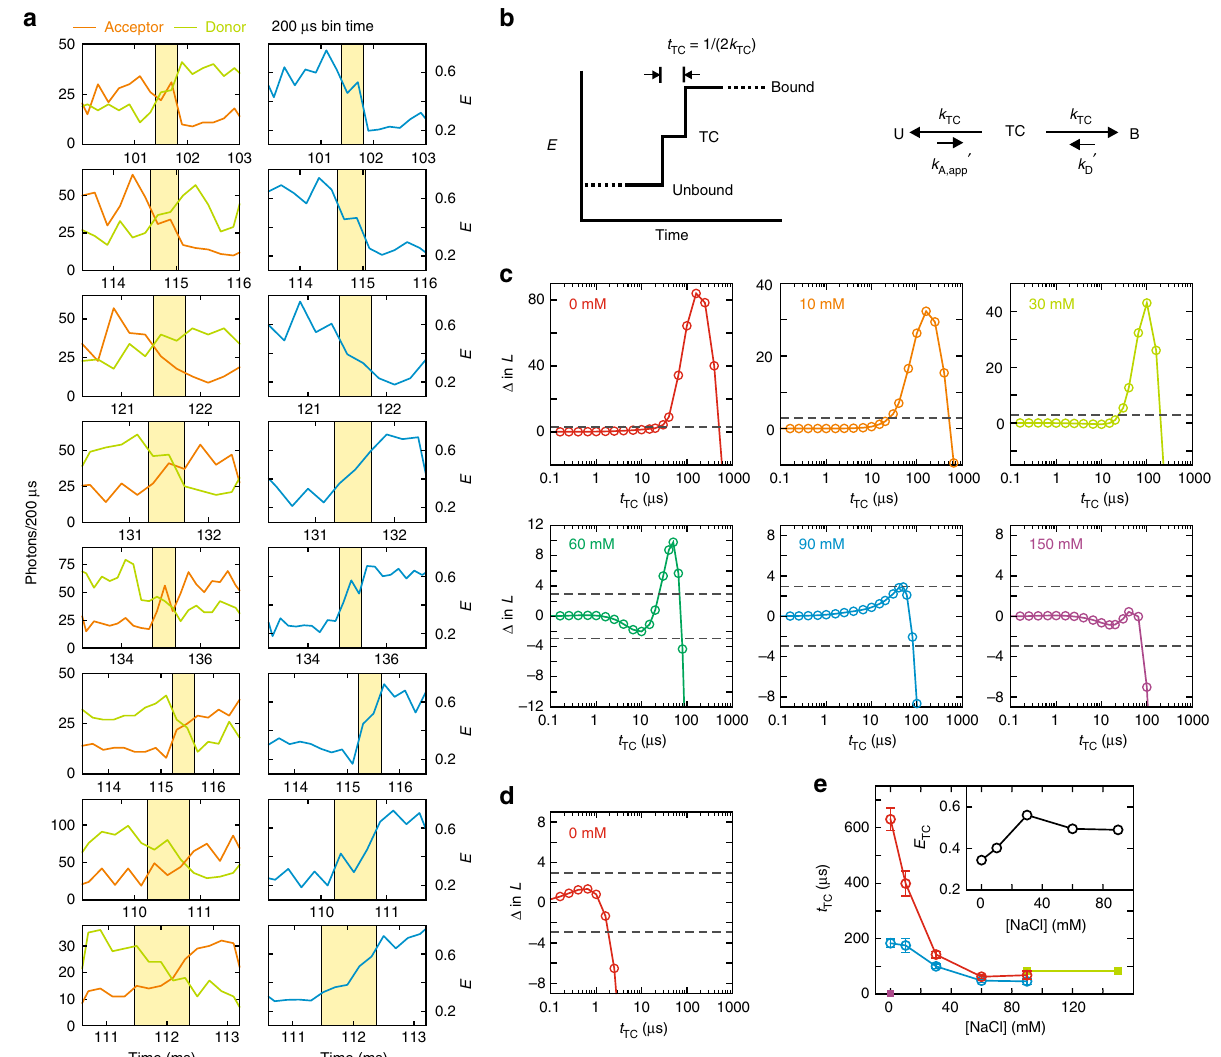
Fig. 3 Measurement of the lifetime of transient complex. a Selected donor and acceptor fl uorescence trajectories (left) and FRET ef fi ciency trajectories (right) collected at high illumination intensity (200 μ s bin time) that exhibit gradual changes in the fl uorescence intensities and FRET ef fi ciency (yellow shade) during association and dissociation. The accurate lifetime of TC was determined using the maximum likelihood analysis of photon trajectories without binning (see e ). b Three-state model to determine the lifetime of TC ( t TC ). The two rate coef fi cients of the transitions from TC to the bound and unbound states are set to be equal ( k TC ) for the convenience of the analysis, which does not re fl ect the actual relative heights of the two barriers in Fig. 4c. c The difference of log-likelihood ( Δ ln L ) plots for binding of TAD and NCBD as a function of t TC at various NaCl concentrations (quoted numbers). Δ ln L = ln L ( t TC ) − ln L (0) compares the likelihood of the three-state model with a fi nite lifetime, t TC , with the model with an instantaneous transition ( t TC = 0). The FRET ef fi ciency of TC is assumed to be the average of the bound and unbound FRET ef fi ciencies ( E TC = ( E B + E U )/2). When the peak of the likelihood is signi fi cantly higher than the 95% con fi dence level ( Δ ln L = + 3, upper dashed line), t TC can be determined from the time at the maximum. When there is no signi fi cant peak, the upper bound of the lifetime can be determined from the time where Δ ln L crosses the lower 95% con fi dence level ( Δ ln L = − 3, lower dashed line). d Δ ln L plotted for binding of barnase and barstar at 0 mM NaCl. e The dependence of t TC on the NaCl concentration. t TC of TAD and NCBD binding is determined from either the maximum of Δ ln L in c (blue) or by maximizing Δ ln L with E TC as a free parameter (red, see Methods). Fitted values of E fi lled squares are the upper bound of t fi lled square is the upper bound of t TC are shown in the inset. Green TC at 90 and 150 mM NaCl. A purple TC of barnase and barstar binding at 0 mM NaCl in d . Fitting parameters are also listed in Supplementary Table 2. Errors are standard deviations obtained from the diagonal elements of the covariance matrix calculated at the maximum of the likelihood